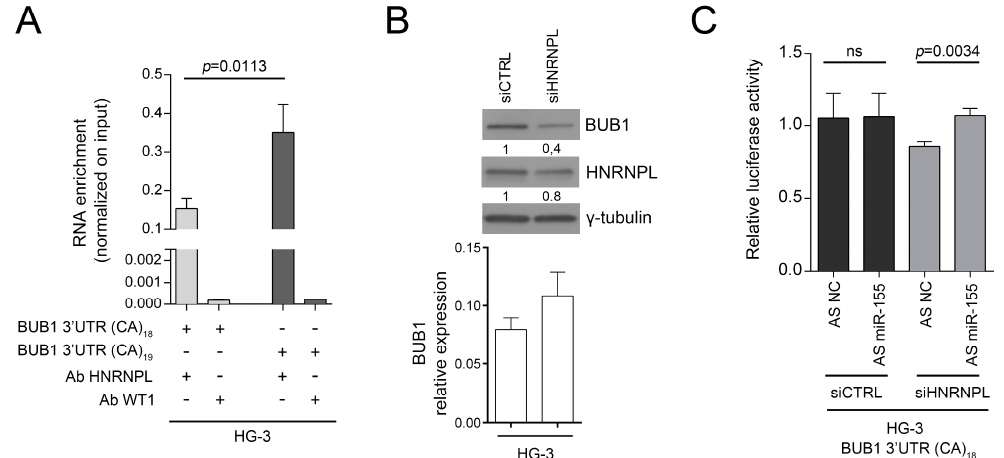
Figure 4. HNRNPL binding to CA repeats influences BUB1 targeting by miR-155 . ( A ) BUB1 3 (cid:48) UTR mRNA quantification in RNA immunoprecipitated with either the anti-HNRNPL or the anti-WT1 antibody (as negative control) from HG-3 cells transfected as indicated. Data are means ± SD of three technical replicates normalized to the RNA input. p -value was calculated using the unpaired Student t -test, two-tailed. ( B ) Upper, protein expression levels of HNRNPL and BUB1 (120 kDa) in HG-3 cells transfected with either siRNA control (siCTRL) or siRNA of HNRNPL (siHNRNPL) for 72 h; bottom, BUB1 mRNA relative expression was normalized to the endogenous reference β -actin (2 − ∆ ct method). Data are means ± SD of three technical replicates ( C ) Luciferase assay in HG-3 cells transfected with siRNA control or siRNA of HNRNPL for 48 h, and subsequently re-transfected with psiCHEK_2 3 (cid:48) UTR BUB1 (18CA) vector in combination with anti-miR Negative Control (NC) or anti-miR-155 (AS miR-155) for additional 24 h. Data are means ± SD of three technical replicates of three independent transfections. The p -value was calculated using the unpaired Student t -test,